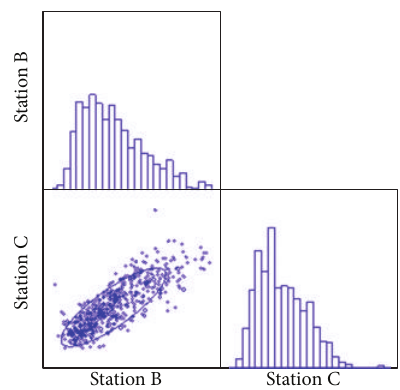
Figure 5: Pearson correlation matrix of ASI measurement data at station B and station C (July 11 to September 3, 2007).